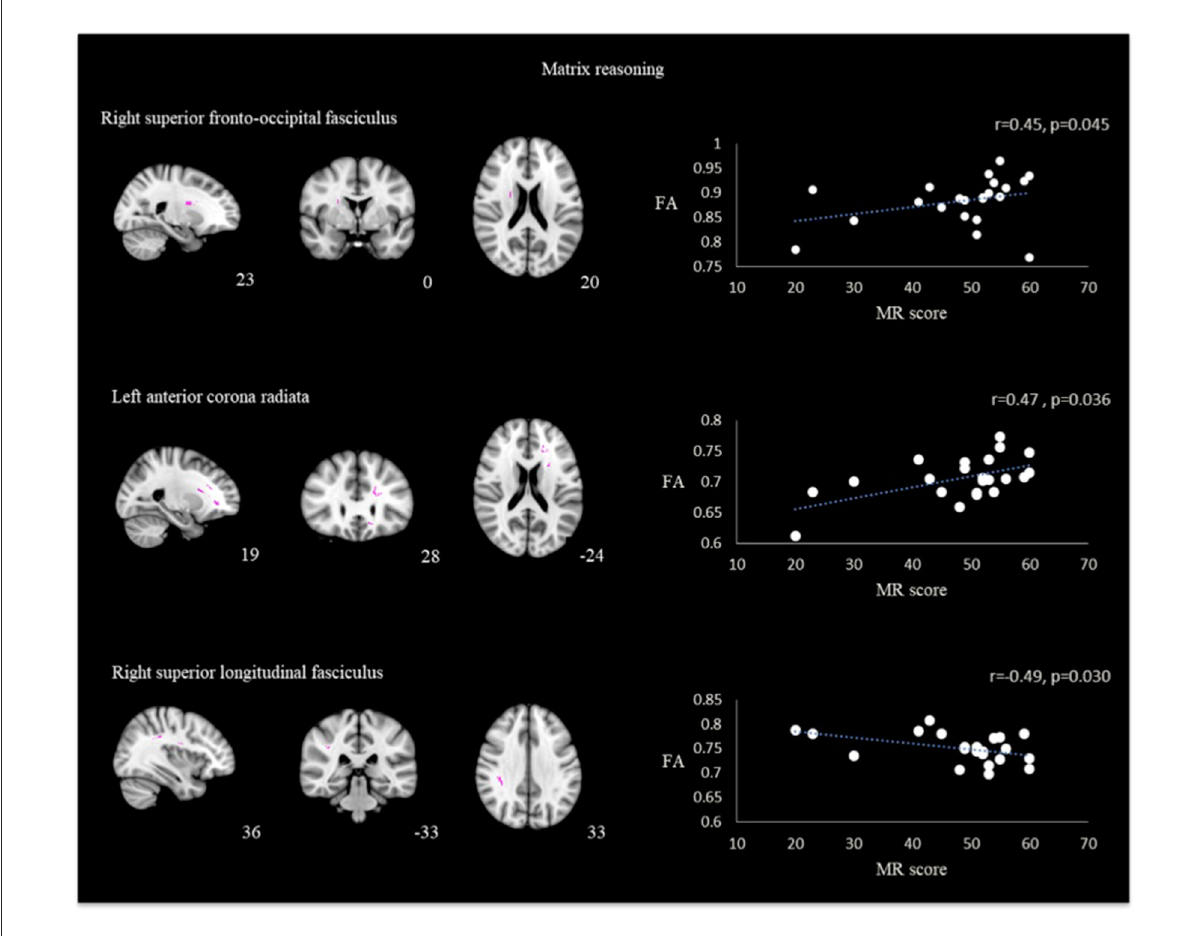
FIGURE3 Correlation between FA and matrix reasoning scores in the region of right superior fronto-occipital fasciculus, left anterior corona radiata and right superior longitudinal fasciculus in TBI patients.